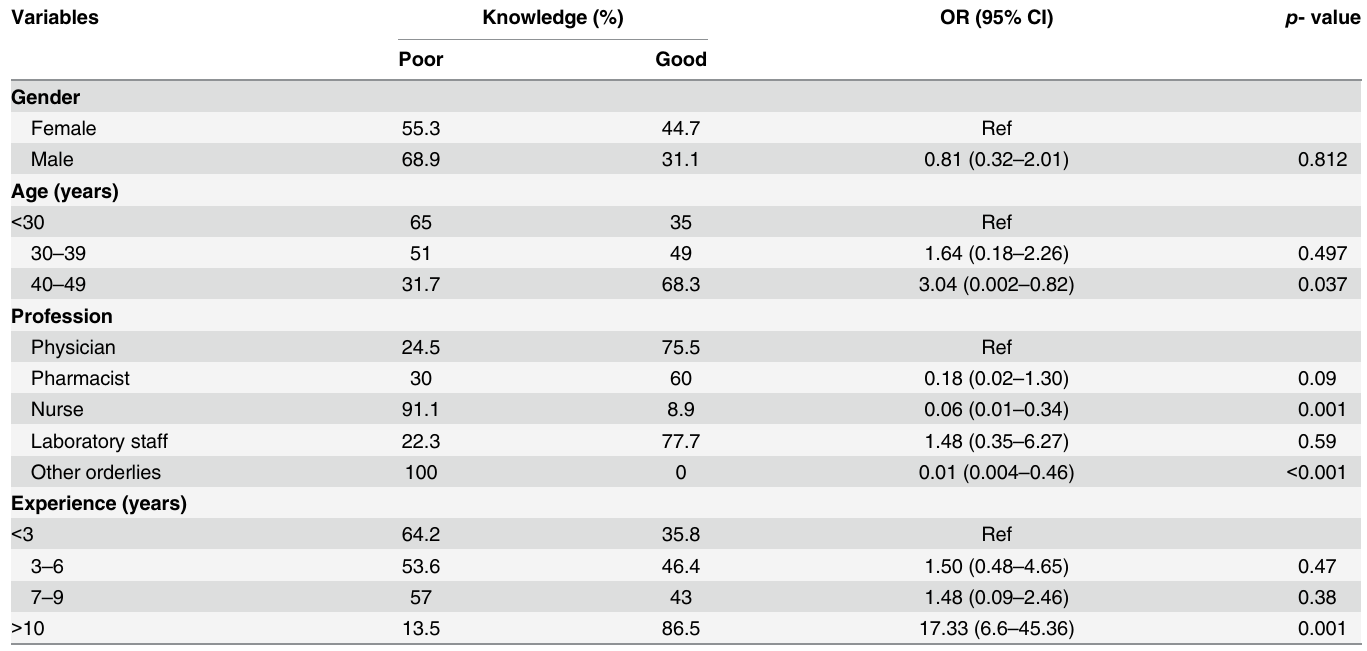
Table 3. Association of demographic variable with the knowledge of participants towards Japanese Encephalitis (N =